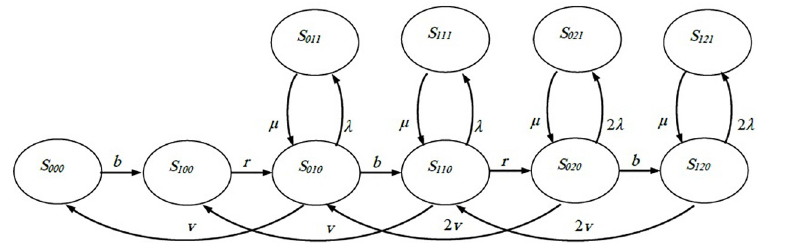
Fig 3. State transition diagram of double-machine